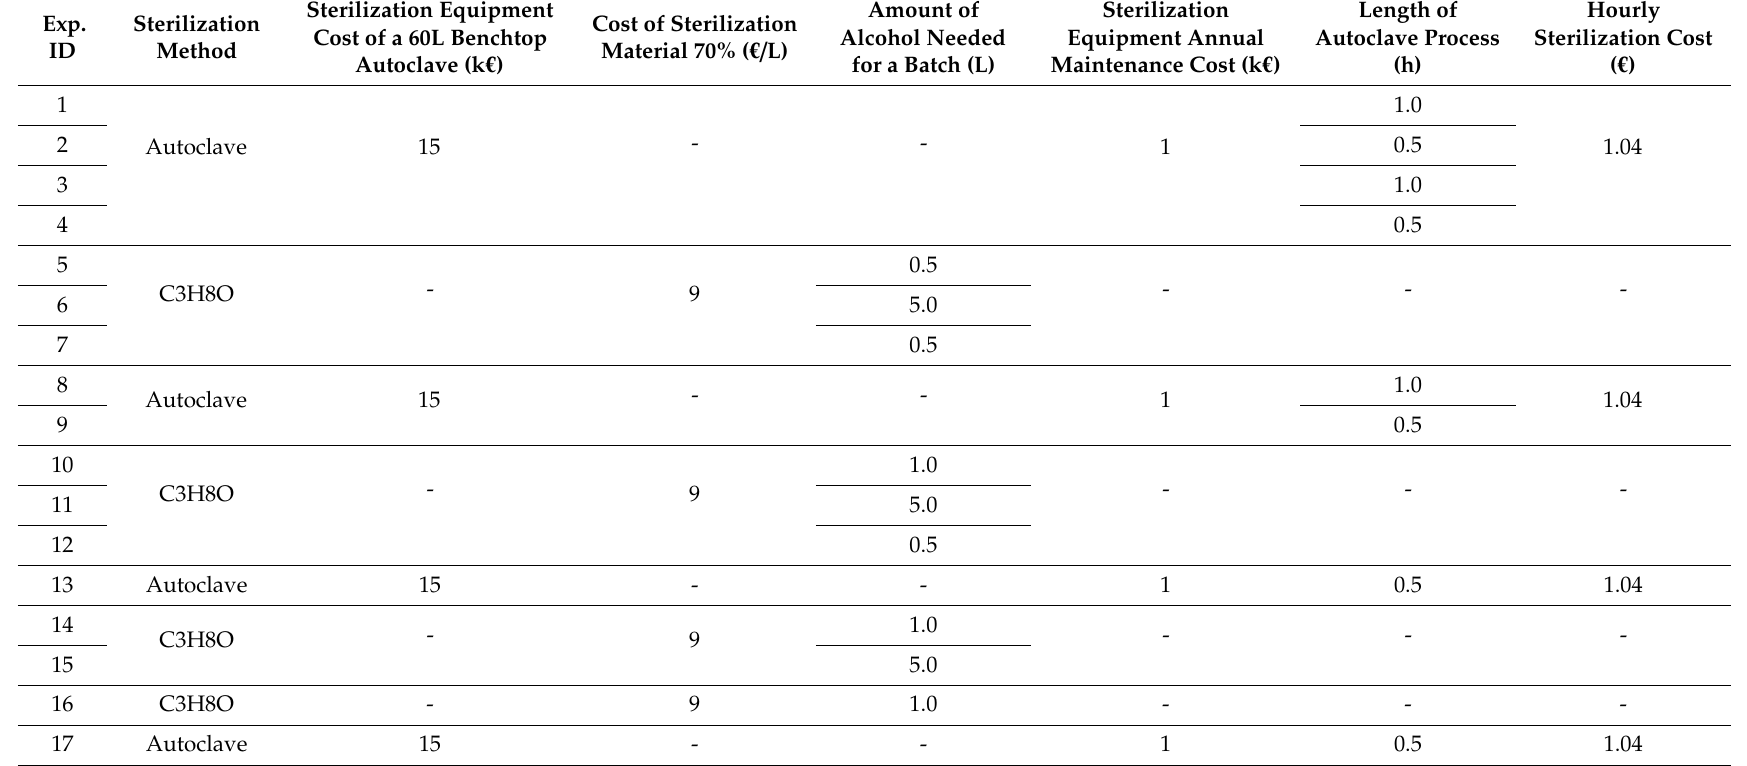
Table 5. Sterilization cost model